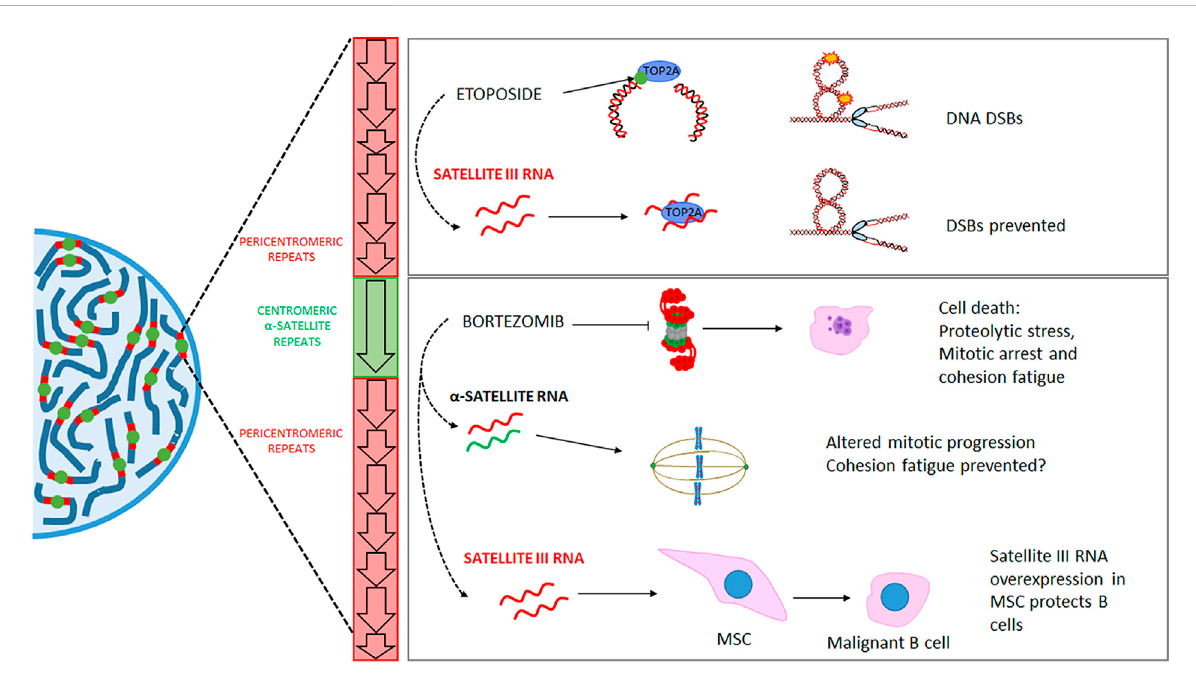
FIGURE 2 Mechanisms proposed to mediate the relationship between RNAs transcribed from the centromere and pericentromere and treatment response. Upper right panel: etoposide promotesDNAdouble-strand breaks (DSBs) through itsinteraction with topoisomerase 2 A (TOP2A) and the formation ofaternary complexwith the DNA. Etoposide-induced satellite III RNAs participateinsequestering TOP2A in nuclear stress bodies, which prevents the generation of DNA DSBs. Lower right panel: Proteasome inhibition by bortezomib (used in treating multiple myeloma, among other malignancies) promotes cell death through proteolytic stress and a prolonged mitotic, followed by cohesion fatigue (among other mechanisms). Upon bortezomib treatment, delayed mitotic progression is associated with the overexpression of α -satellite RNAs. These transcripts interact with cohesin subunits, which could inhibit the establishment of cohesion fatigue. On the other hand, the expression of satellite III RNAs in mesenchymal stromal cells (associated with B-lymphocytes in the bone marrow) triggered by bortezomib has been shown to protect malignant B cells (the target of bortezomib) from bortezomib toxicity. DSB: Double Strand Breaks. MSC: Mesenchymal Stromal